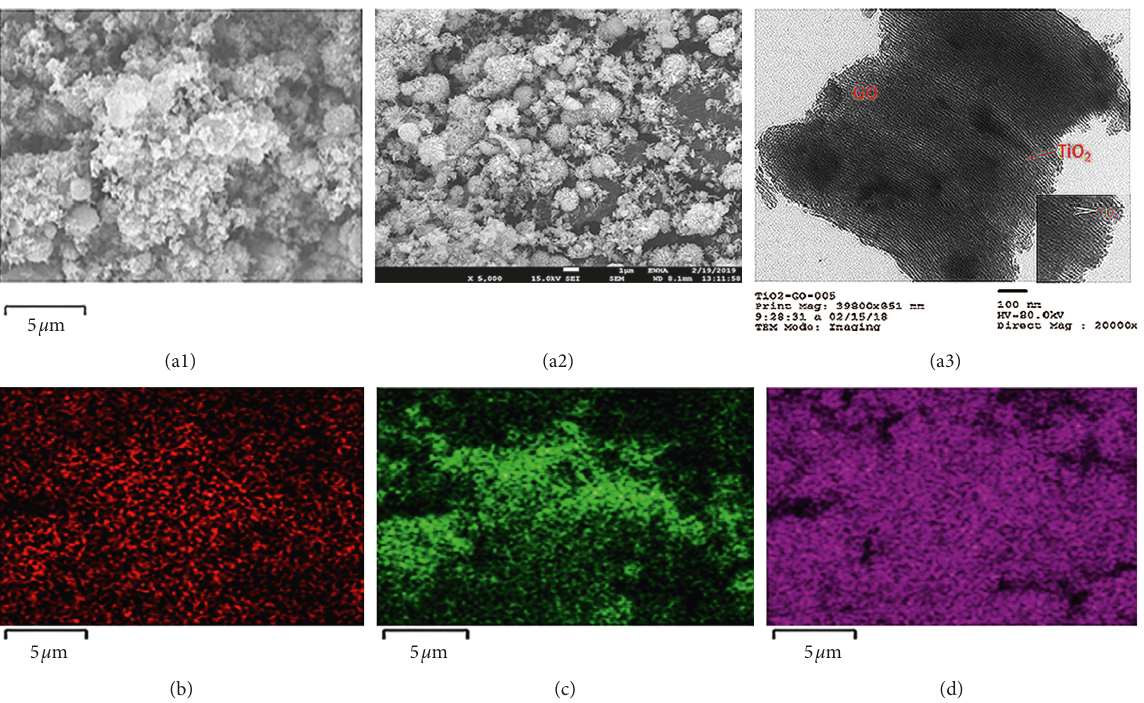
Figure 3: SEM (a1, a2), TEM (a3), and EDX-mapping images of C K series (b), O K series (c), and Ti K series (d) elements of GO-TiO materials.